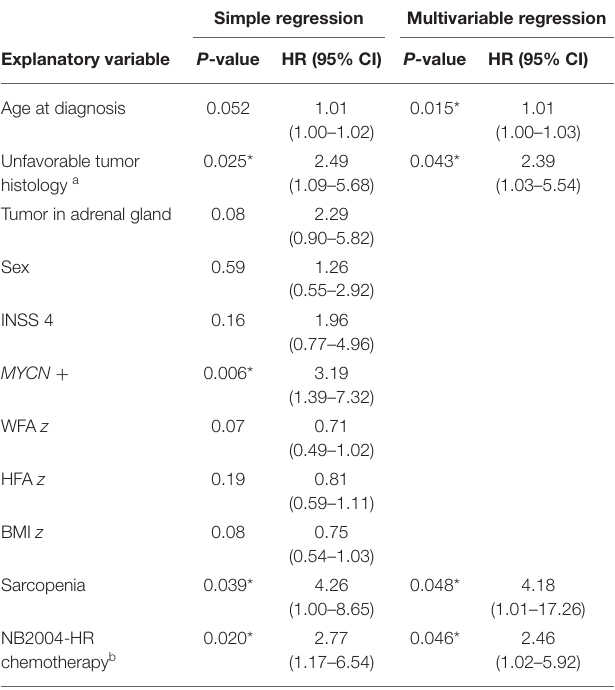
TABLE 3 | Analysis of pre-operative risk factors influencing 5-year mortality. Simple regression Multivariable